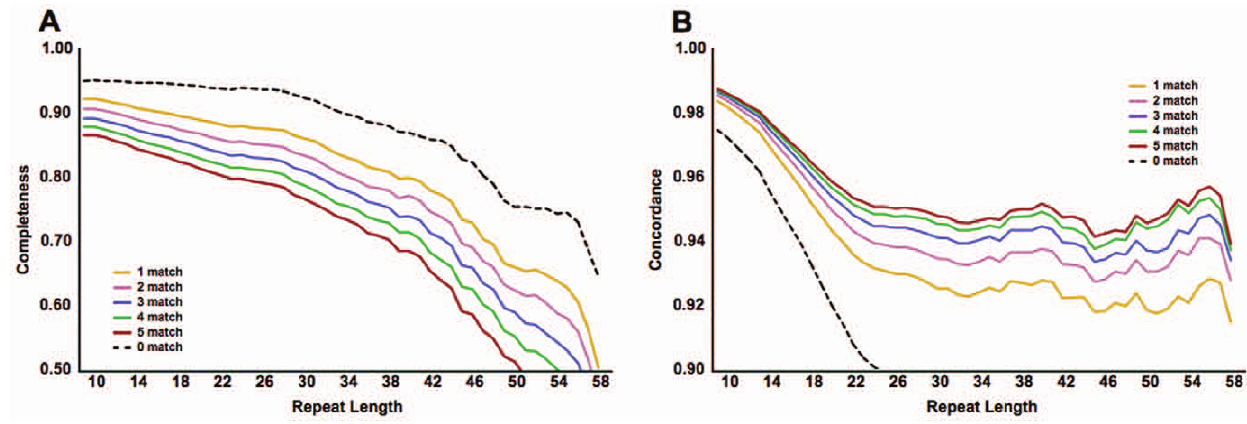
Figure 4. Increasing the requisite number of matching flank bases between a read and the reference improves genotyping accuracy at the expense of coverage. The minimum required number of matching flanking bases for a read to be scored was incremented from zero to five. Two or more scorable reads were required to determine a repeat genotype. The plotted values are the mean (A) completeness (fraction of repeats with at least two reads passing filtering criteria) and (B) concordance for the genomes in the DGRP panel. Data have been smoothed for clarity (unweighted mean with window size 6 2 bases).